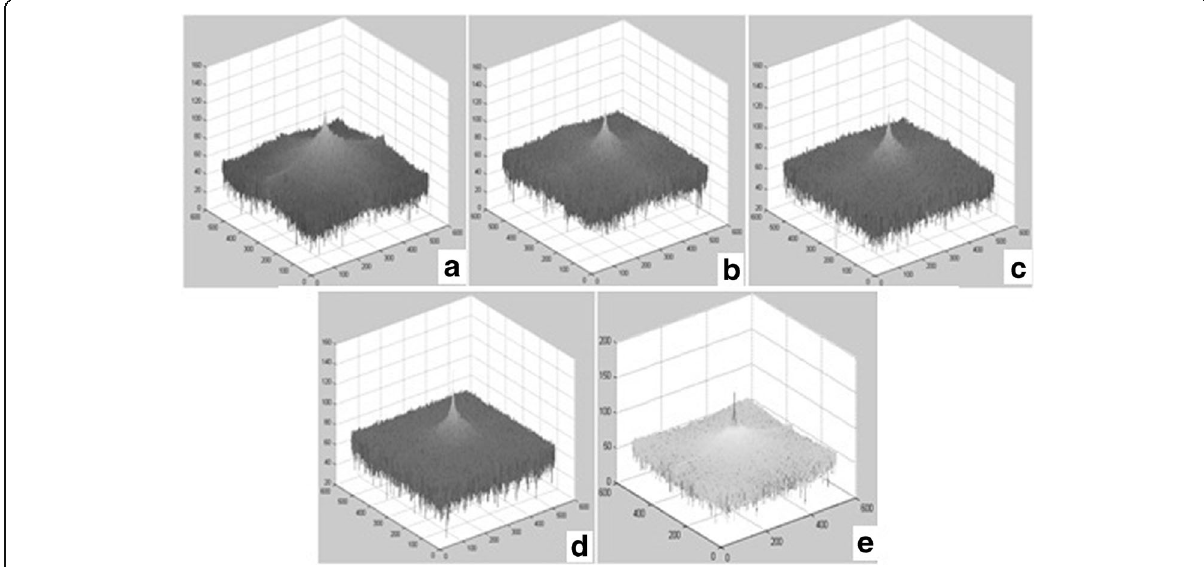
Fig. 15 Frequency spectrum of different adaptive weighted methods on Boat image corrupted by 90% salt and pepper noise a DBIDWIF, b ACBSA, c NAFSM, d AMF, and e AWMF